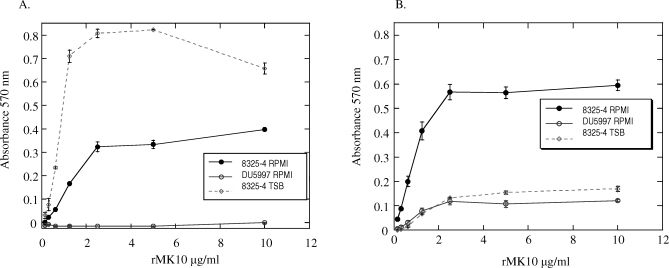

S. aureus Adherence to Recombinant Cytokeratin 10 in Different Growth StagesData are epresentative of three independent experiments. Bars represent standard deviation.(A) Adherence of bacterial cells in exponential phase of growth to rMK10. Strain 8325–4 was grown to exponential phase in RPMI or TSB, and its ability to bind rMK10 was compared to DU5997 grown in RPMI.(B) Adherence of bacterial cells in stationary phase of growth to rMK10. Strain 8325–4 was grown to stationary phase in RPMI or TSB, and its ability to bind rMK10 was compared to DU5997 grown in RPMI.